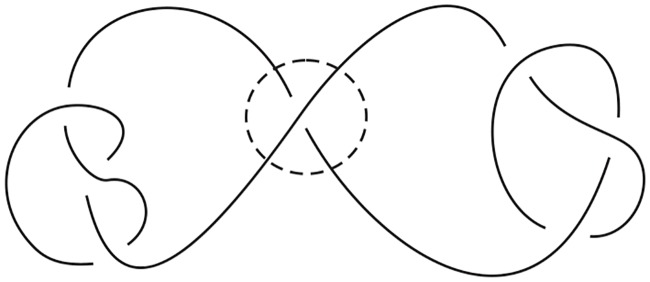
A nugatory crossing.